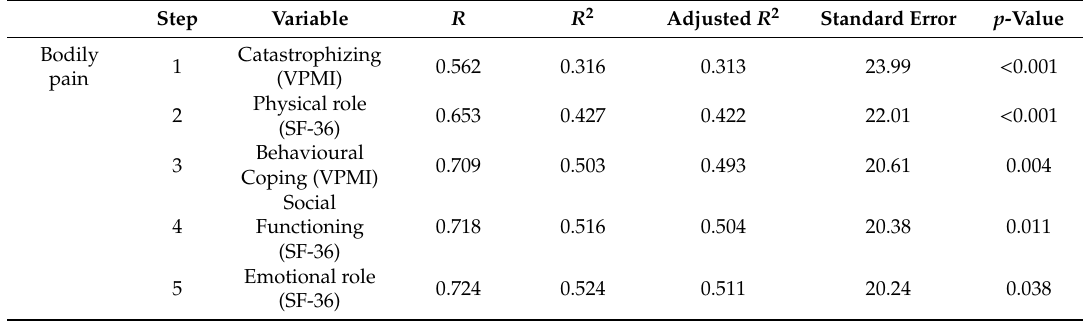
Results of the stepwise multiple regression analysis for bodily pain with non-participants / participants, clinical characteristics, VPMI dimensions, rest of SF-36 dimensions and IPAQ.